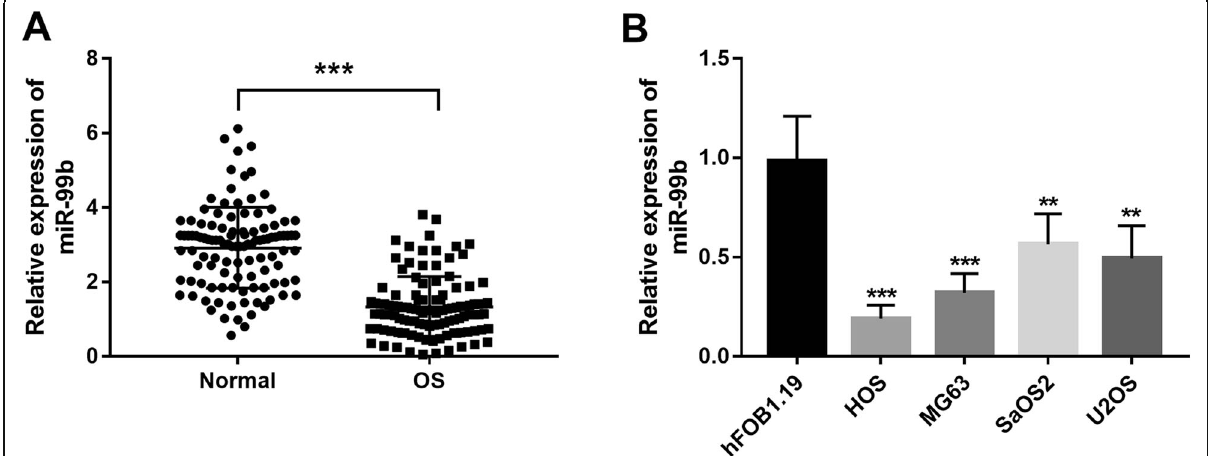
Fig. 1 Expression of miR-99b examined by qRT-PCR in OS. a Expression of miR-99b was decreased in OS tissues compared with the normal tissues. b Expression of miR-99b was downregulated in the four OS cell lines compared with the normal cells. ** P < 0.01, ** P < 0.001